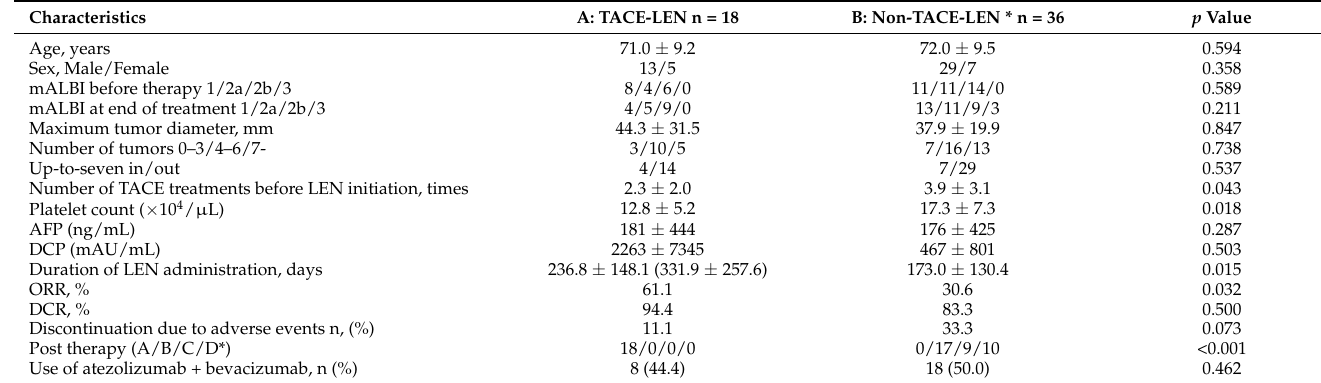
Table 4. Characteristics of post-treatment in patients for whom lenvatinib therapy was